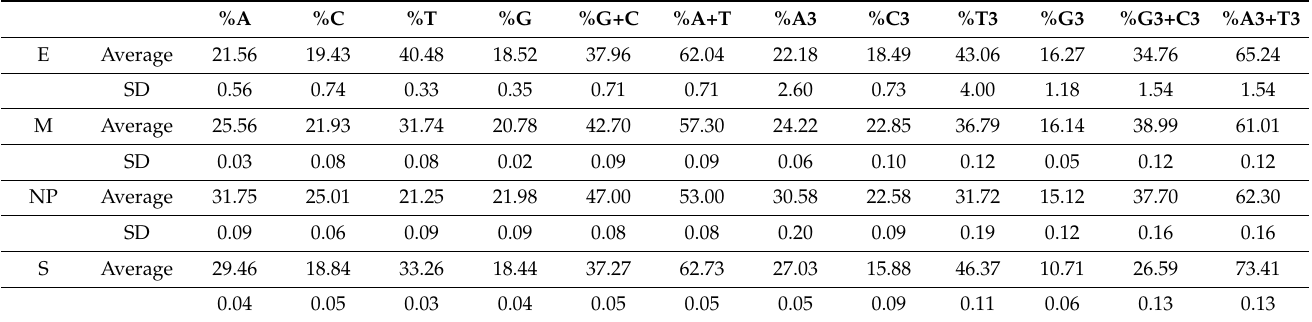
Table 1. Average nucleotide composition of structural genes of SARS-CoV-2 delta